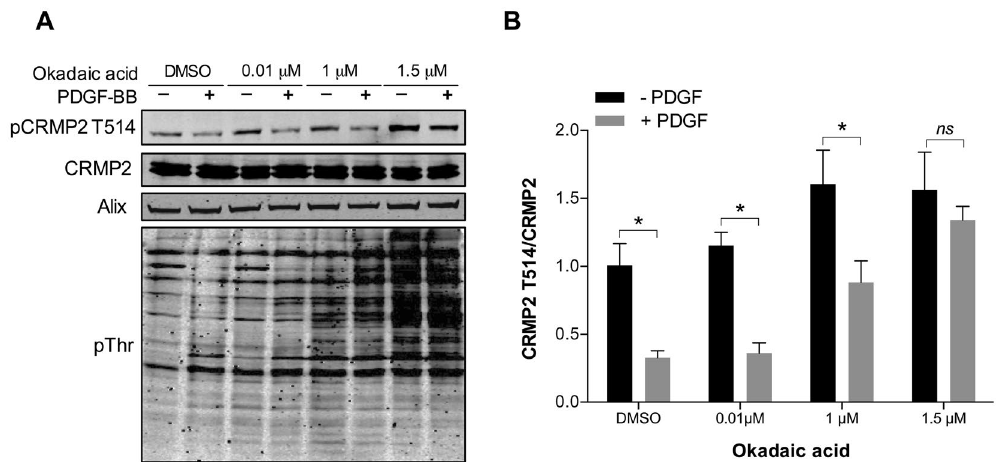
Figure 6. PP1 dephosphorylates CRMP2 Thr514 in response to PDGF stimulation. ( A ) MEFs were incubated with either DMSO or okadaic acid (0.01 μ M, 1 μ M or 1.5 μ M) for 30 min prior to stimulation with 20 ng/ mL PDGF for 7 min. CRMP2, CRMP2 Thr514, total phospho-threonine and Alix were analysed by Western blotting. For uncropped images of blots see Supplementary Fig. S3. ( B ) Western blots were quantified and ratios of pCRMP2 to CRMP2 were plotted ( * P <